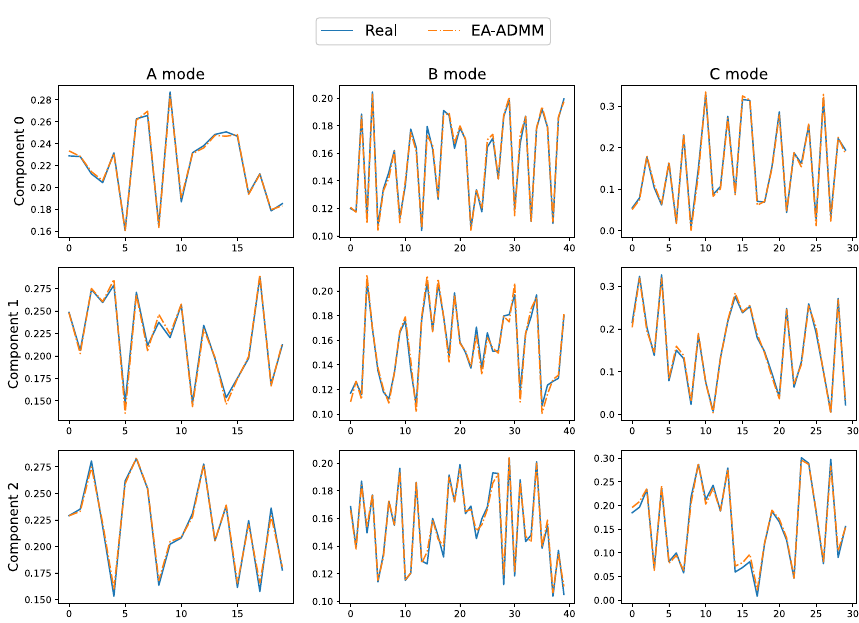
Fig. 5 Tensor completion performance when the missing rate as 0.1 and ˆ µ = 0